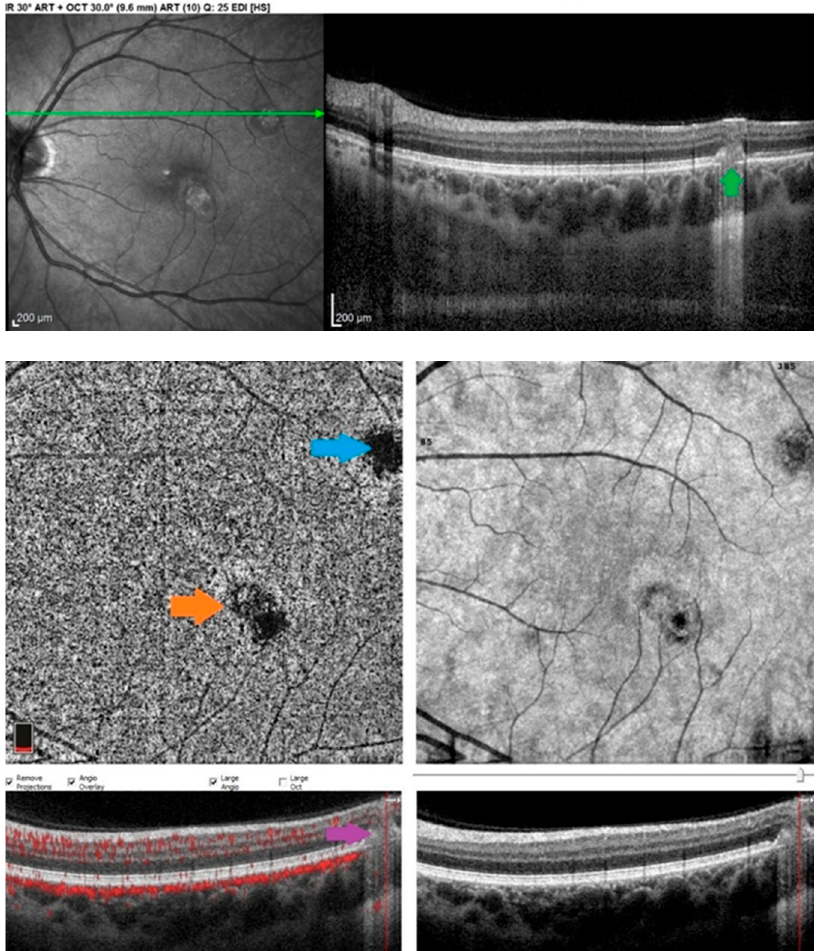
Figure 3. Inability of OCT-A to show active versus inactive choroidal neovessels. Upper image: OCT cross-sectional scan of an active MFC lesion (green arrow), which presents as a dark spot in choriocapillaris en-face OCTA scan (blue arrow, middle left ) due to choriocapillaris drop-out, as well as absence of flow in cross-sectional scan (Crimson arrow, lower left ). The orange arrow pinpoints a dark lesion with a flow detection inside, corresponding to iCNV, which in this case was